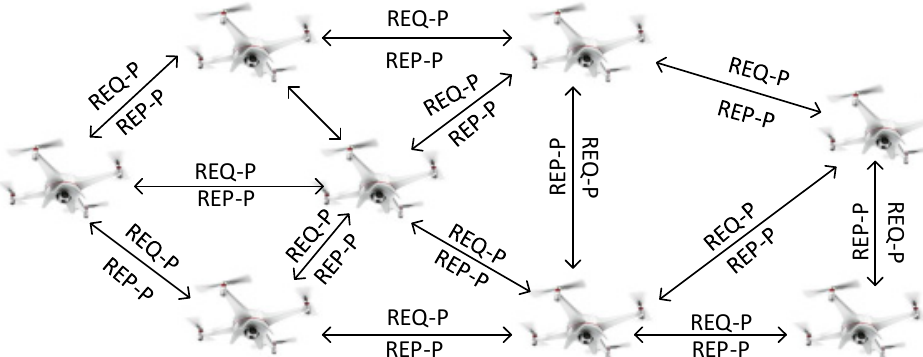
Figure 2. UAVs-BS status update process.